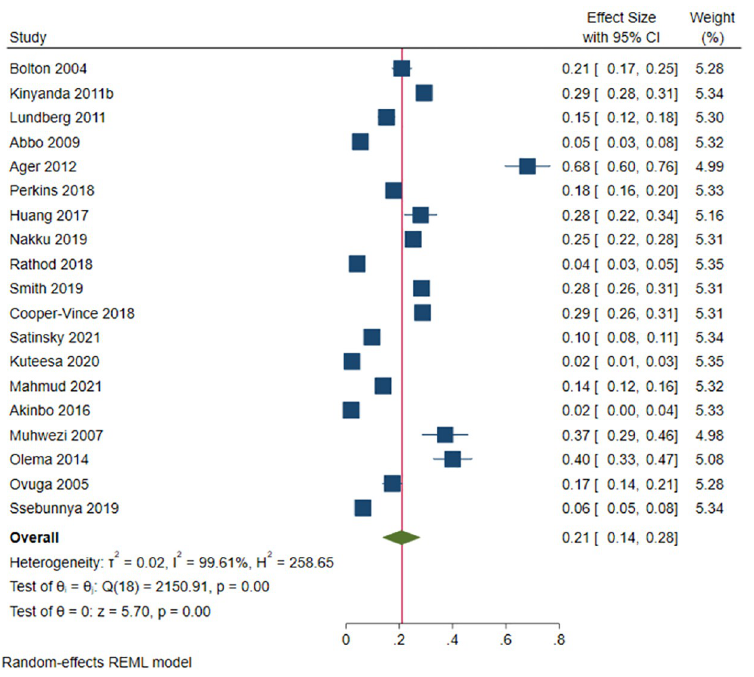
Fig 14. Forest plot on the prevalence of depression among the general population in